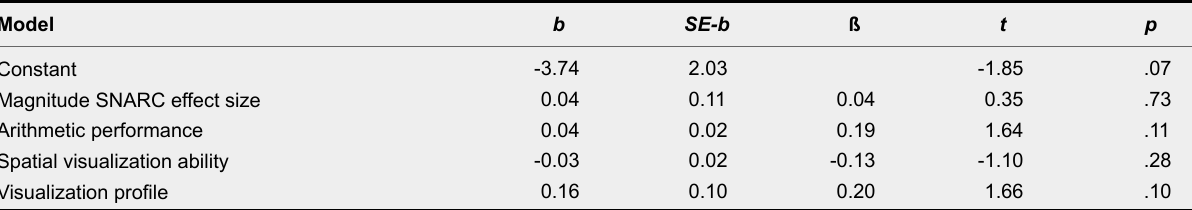
Multiple Linear Regression Analysis on the Parity SNARC Effect Sizes